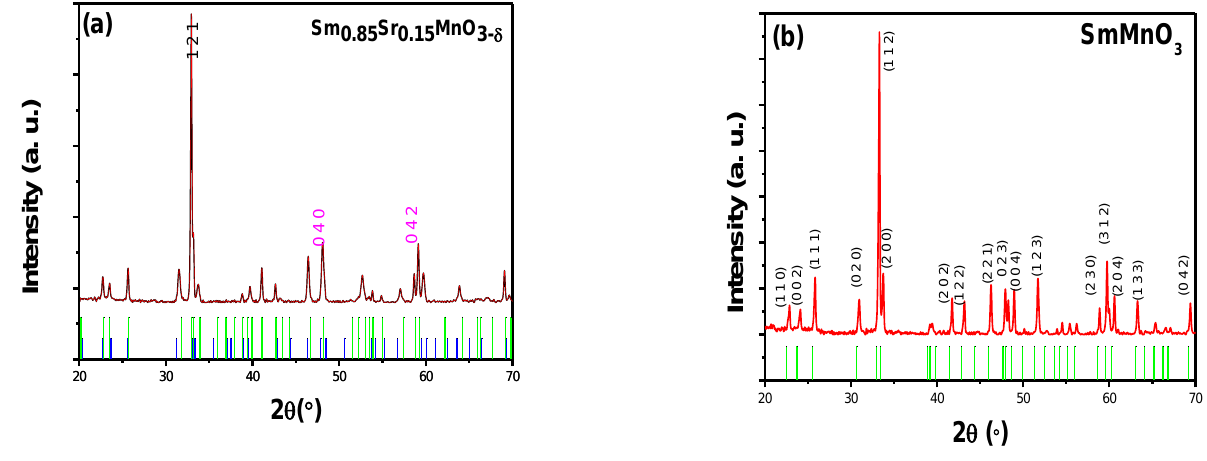
Figure 1. The XRD patterns: ( a ) Sm 0.85 Sr 0.15 MnO 3 - δ and ( b ) SmMnO 3.